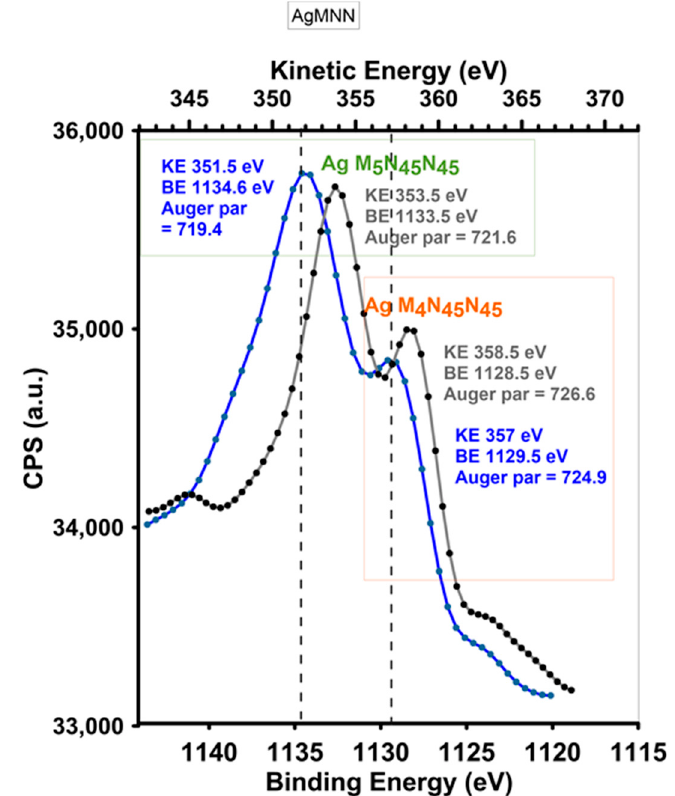
Figure 2. Ag MNN Auger electron spectra of BP/AgP (blue line) and BP/AgNP (grey line) materials. MNN implies the Auger emission type, MNN symbols in the transition label correspond to the three energy levels involved in the transition ( in this case: M 5 N 45 N 45 and M 4 N 45 N 45 ).